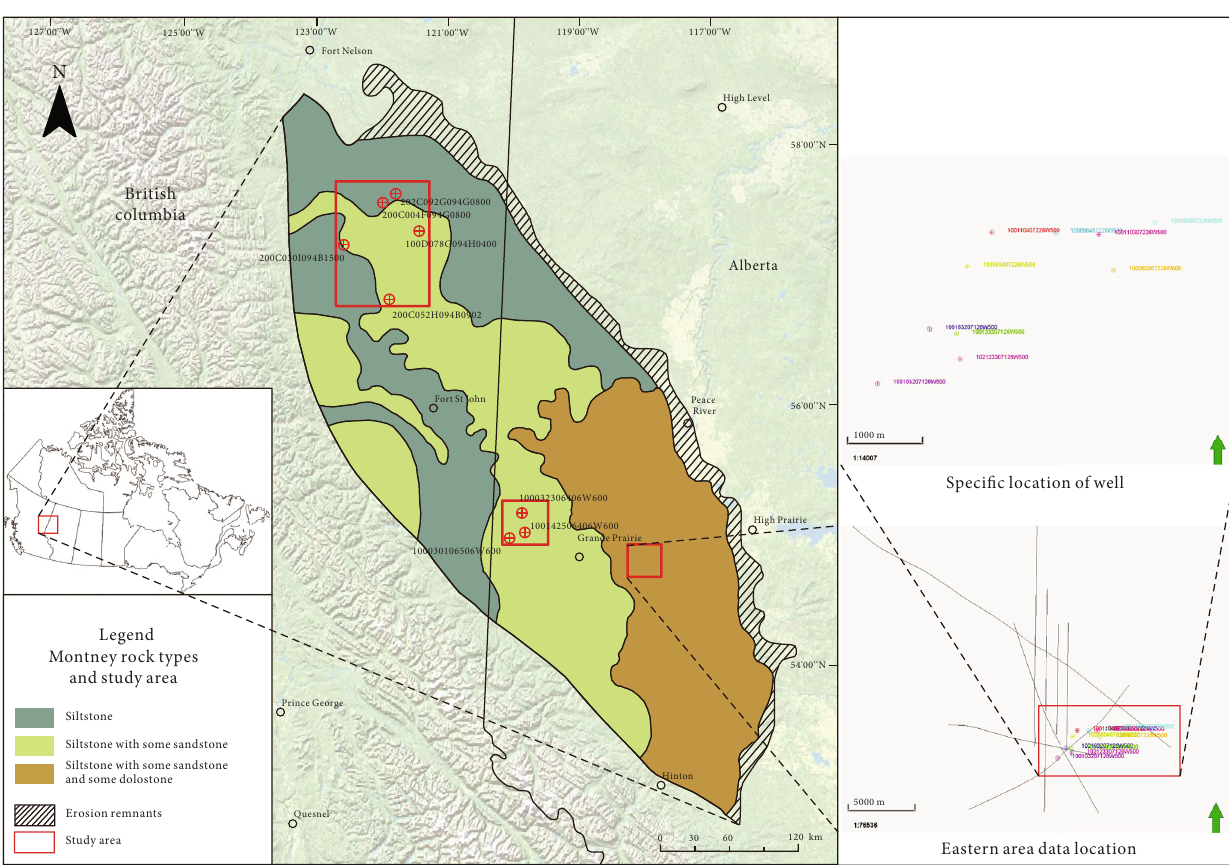
Figure 2: Distribution of the Lower Triassic Montney Formation in southwestern Alberta and northeastern British Columbia province representing its lithology pattern and study area (modi fi ed Yang and Lee [11]). Each well location was displayed. Eastern area data location is magni fi ed to show clear